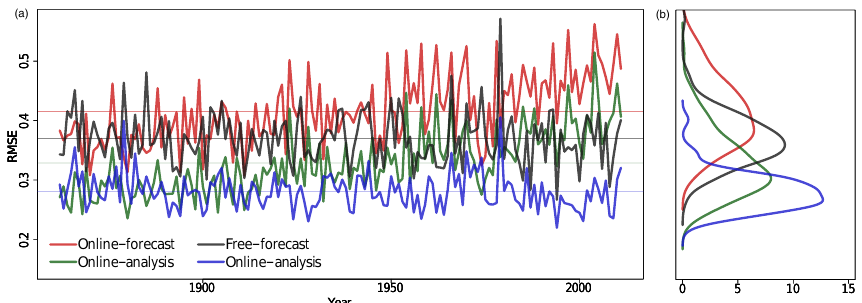
Figure 5. Global near-surface temperature RMSE for the forecast ensemble run constrained by VSL-T pseudo-TRW observation (red) and the free ensemble run (black) for the analysis of online (green) and off-line (blue) DA. Panel (a) shows time series and panel (b) their corresponding histograms. Horizontal lines represent the mean values.